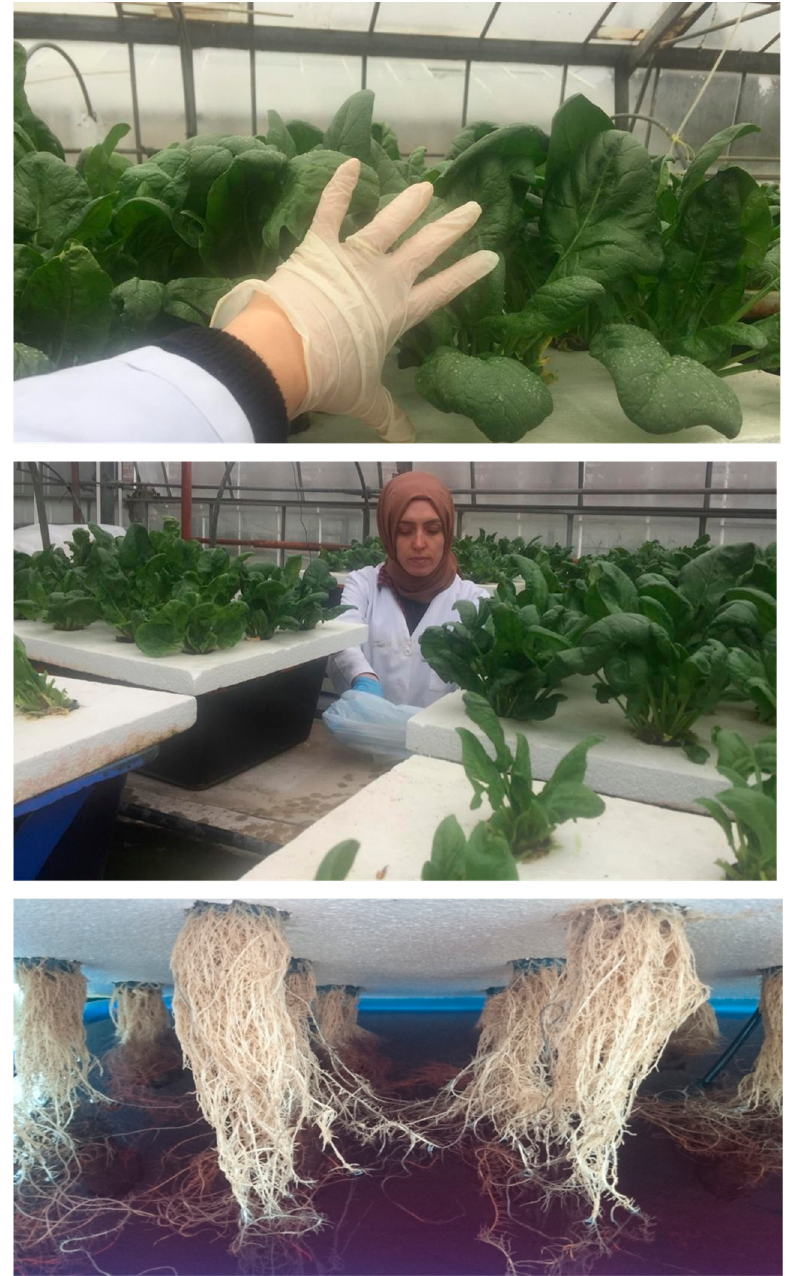
Figure 2. Harvest view of baby spinach leaves grown with biofertilizers in a floating culture.